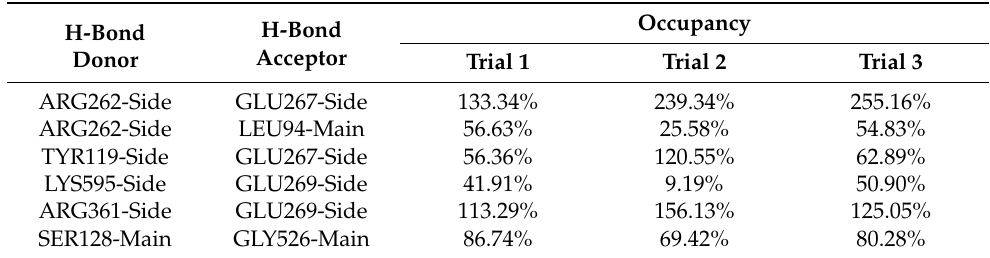
Figure 2. Number of H-bonds in the NS5 homodimer structure throughout the 300 ns production run for 3 trials, along with their 100-pt running averages. Table 1. Hydrogen bond donor and acceptor occupancy within the NS5 protein for three production trials. “Main” signifies that the main chain or the backbone participates in hydrogen bonding, while “Side” signifies that the residue side chain participates in hydrogen